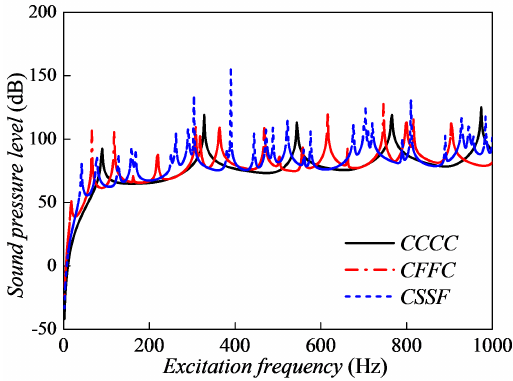
Figure 14: Sound power level with different elastic boundary condi- tions plate when the stiffness value of translational springs k are different. From the Figure 13 and Figure 14, it can be seen that with the increase of stiffness value of translational spring, the peak value varies and exists at different